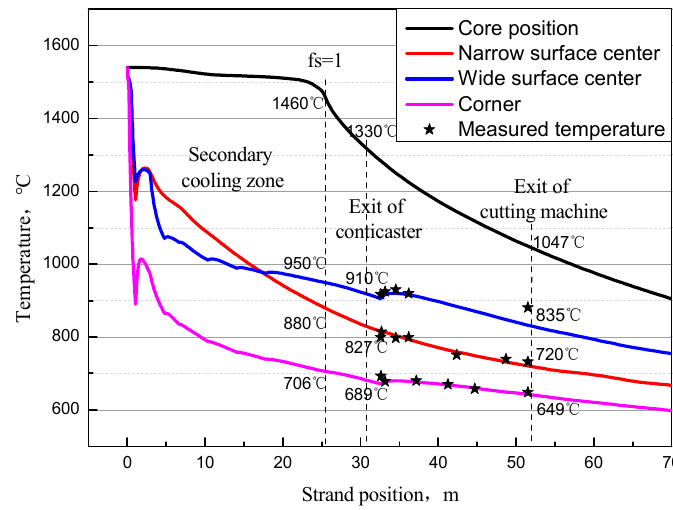
Figure 3. Temperature evolution of the characteristic positions during the continuous casting process.